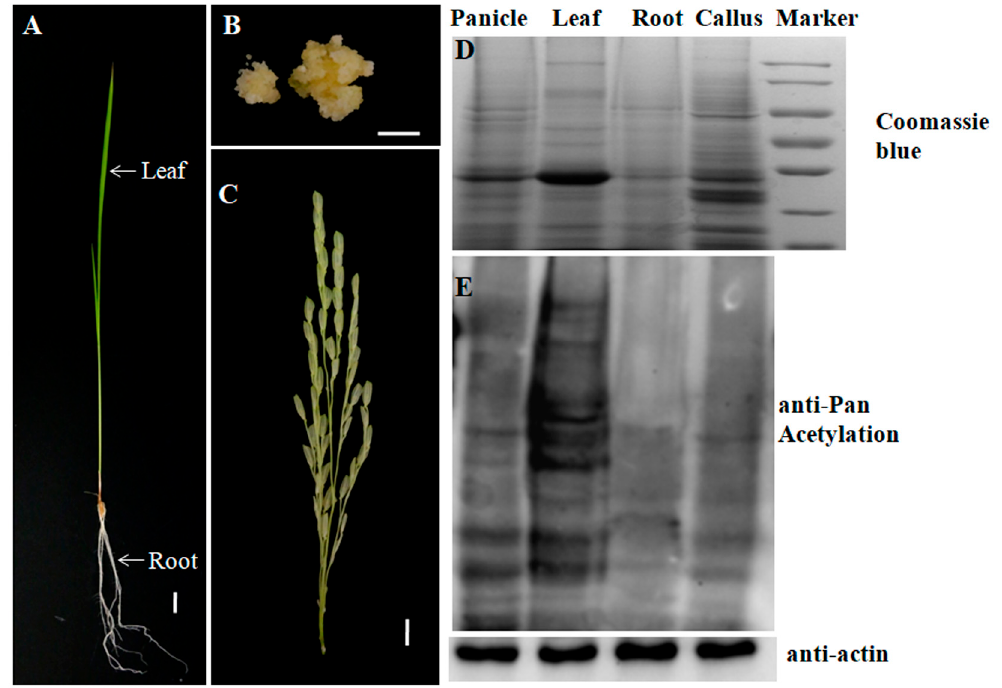
Figure 1. Tissue morphologies of different rice tissues tested in this study. ( A ) leaf and root; ( B ) callus; ( C ) mature panicle. Scale bar = 1 cm; ( D ) Total proteins of different tissues were resolved by SDS-PAGE and stained by Coomassie brilliant blue (CBB) and ( E ) Western blot analysis of the acetylation dynamics in different rice tissues by using anti-acetyl lysine antibodies. Equal amount of proteins (20 µ g) were used. Anti-actin was used as an internal control for normalization [32].